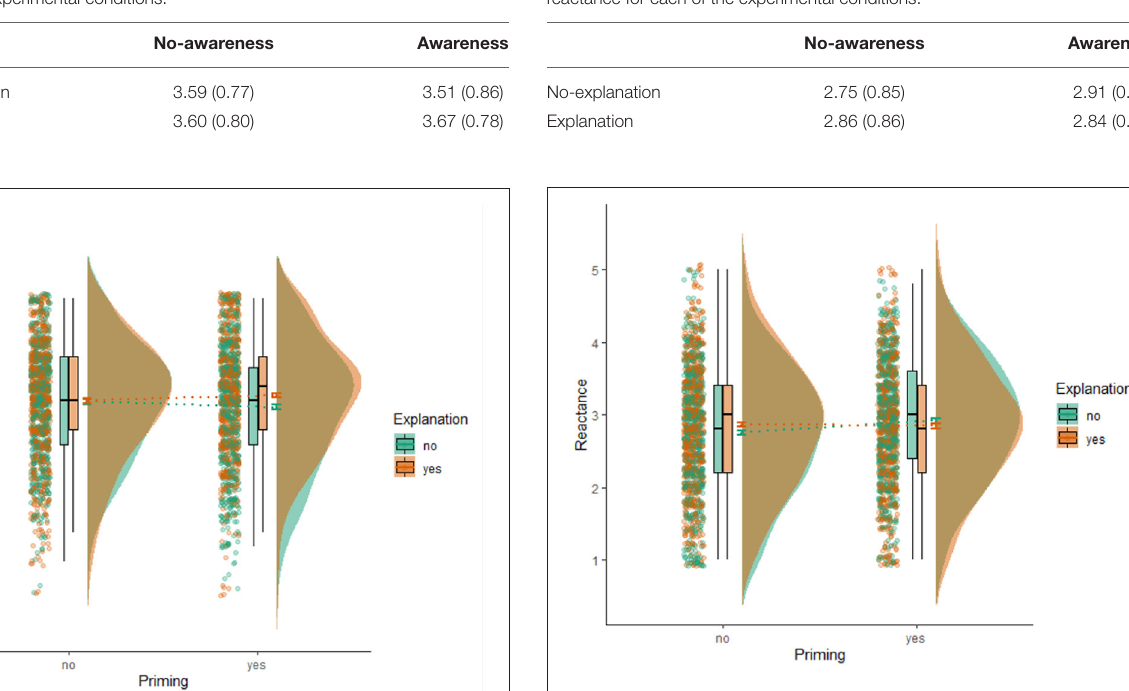
FIGURE 3 | Visualization of means, standard errors, boxplots, distributions, and raw data points of reactance for the four experimental